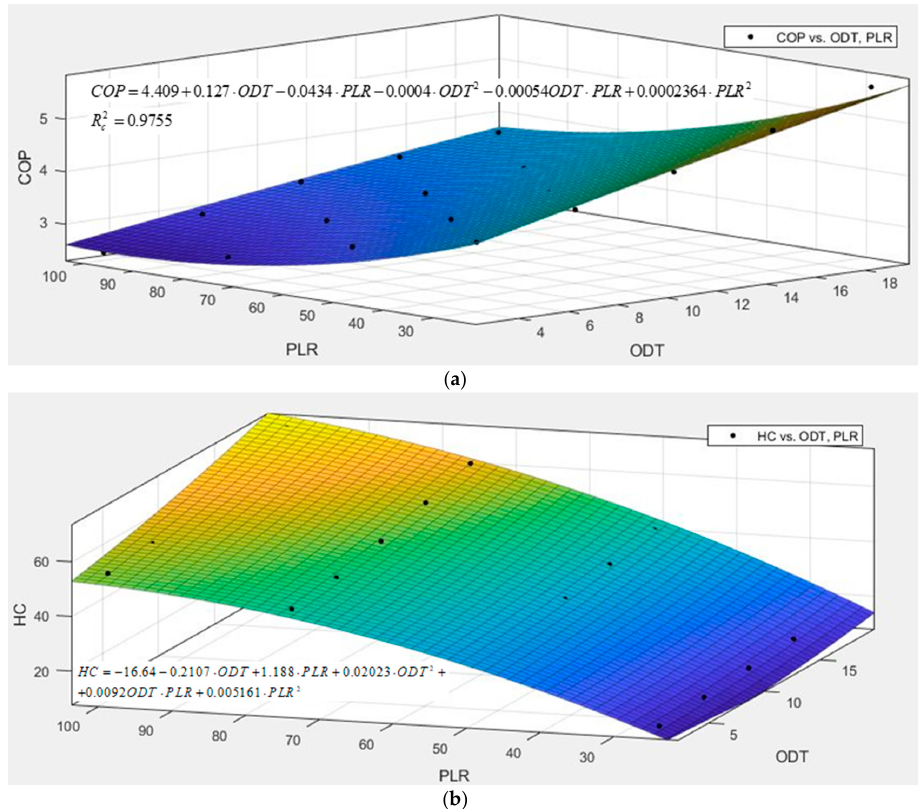
Figure 2. ( a ) Coefficient of performance and ( b ) heating capacity of the reversible HP obtained from IMST-Art Simulations in case. IMST-Art Simulations in